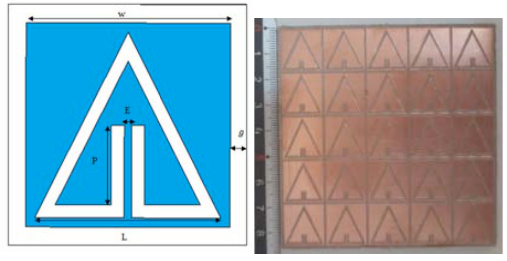
Fig .2. Simulated and measured return loss of CPW antenna.